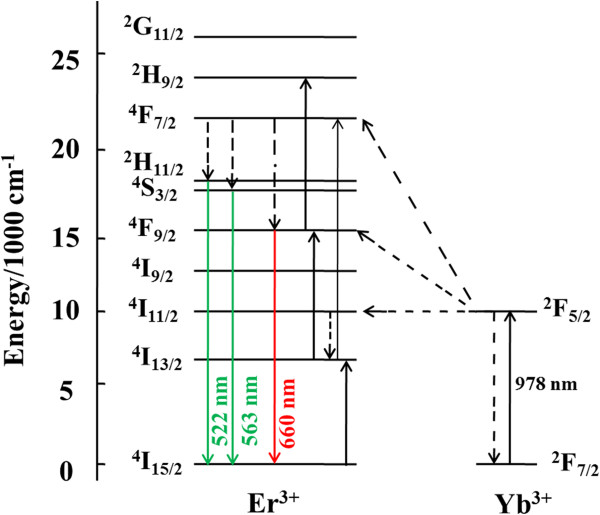
Schematic energy level diagram showing the UC mechanism of Y2O3:Er3+, Yb3+.